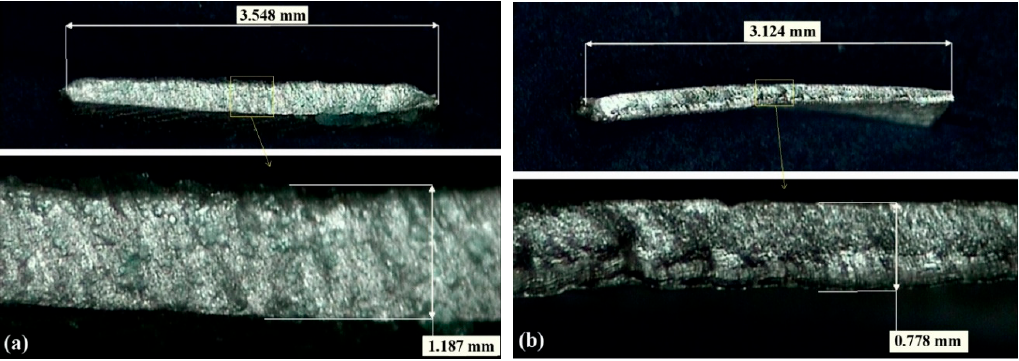
Figure 12. Presentation of chip cross section for different samples, ( a ) FSW zone of FS welded sample, and ( b ) FSW zone of FSV-welded sample.